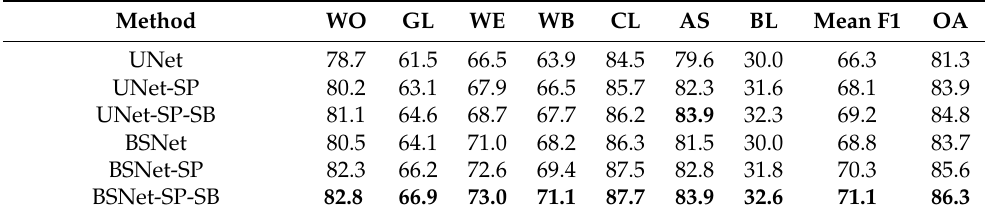
Table 2. The effect of the block shuffle structure, superpixel branch and self-boosting on Landsat core